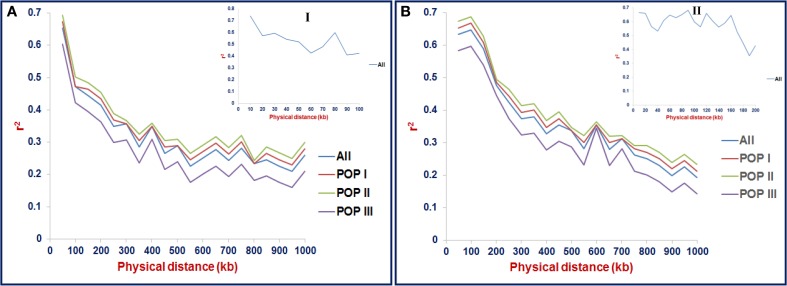
LD decay (mean r2) estimated in three populations (as defined by population genetic structure) using 3321 desi (A) and 8592 kabuli (B) SNPs, respectively. For LD decay, the r2-value of the marker physical distance of 0 kb is considered 1. The plotted curved lines indicate the mean r2-values among markers spaced with uniform 100 kb physical intervals from 0 to 1000 kb. The plotted line in uppermost panel I indicate the mean r2-values among markers spaced with uniform 10 kb physical intervals from 0 to 100 kb. The marked line in panels I, II indicate the mean r2-values among markers spaced with uniform 10 and 20 kb physical intervals from 0 to 100 kb and 0 to 200 kb, respectively. “All” includes the LD decay across entire three populations.